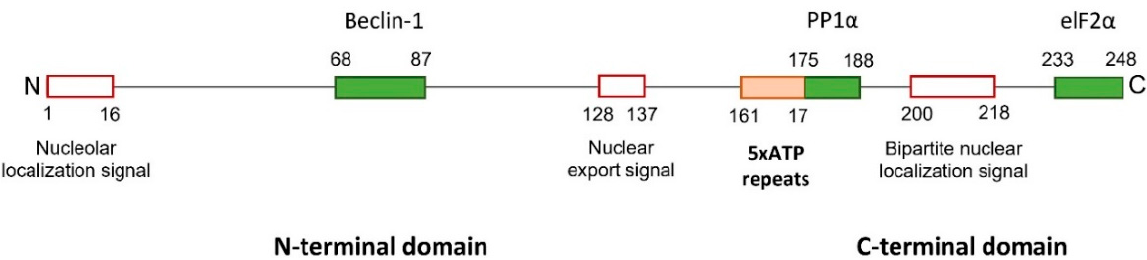
Figure 2. ICP34.5 of HSV-1 strain 17. HSV-1 ICP34.5 is a protein with 248 amino acids that can be divided into three regions: the amino and the carboxyl terminal domains, and a linked tandem of five ATP repeats (161–175 aa) (orange box). The N-terminal region of ICP34.5 contains a nucleolar localization and nuclear export signals, and the C-terminal domain includes a nuclear localization signal (red boxes). Three binding domains (green boxes) have been characterized: the Beclin-1- binding domain (BBD) in the N-terminus, and the PP1 α - and elF2 α -binding domains in the C- terminus.